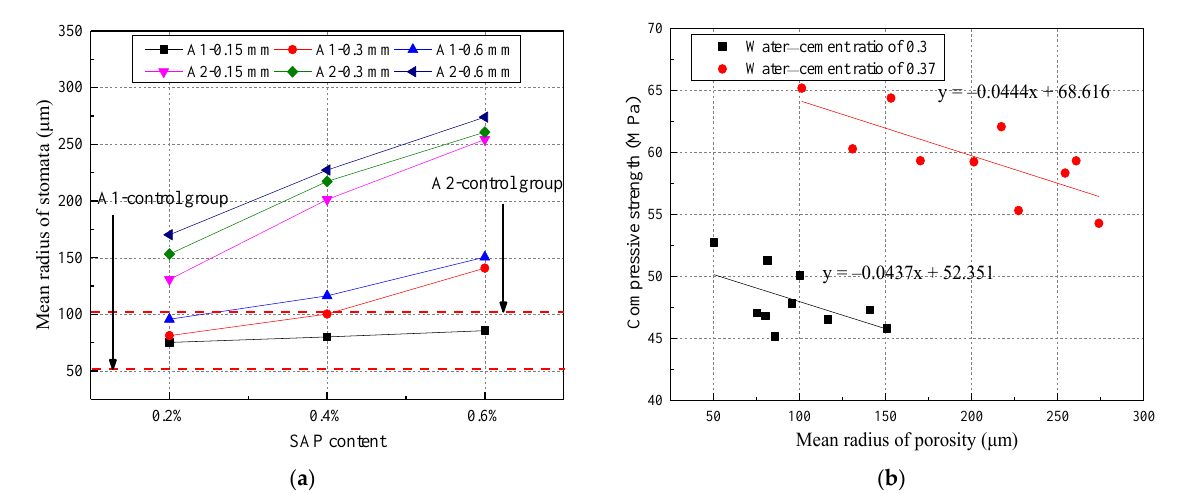
Figure 18. The effect of SAP on the mean radius of stomata under different water–cement ratios: ( a ) different SAP content; ( b ) the relationship between average pore radius and compressive strength.